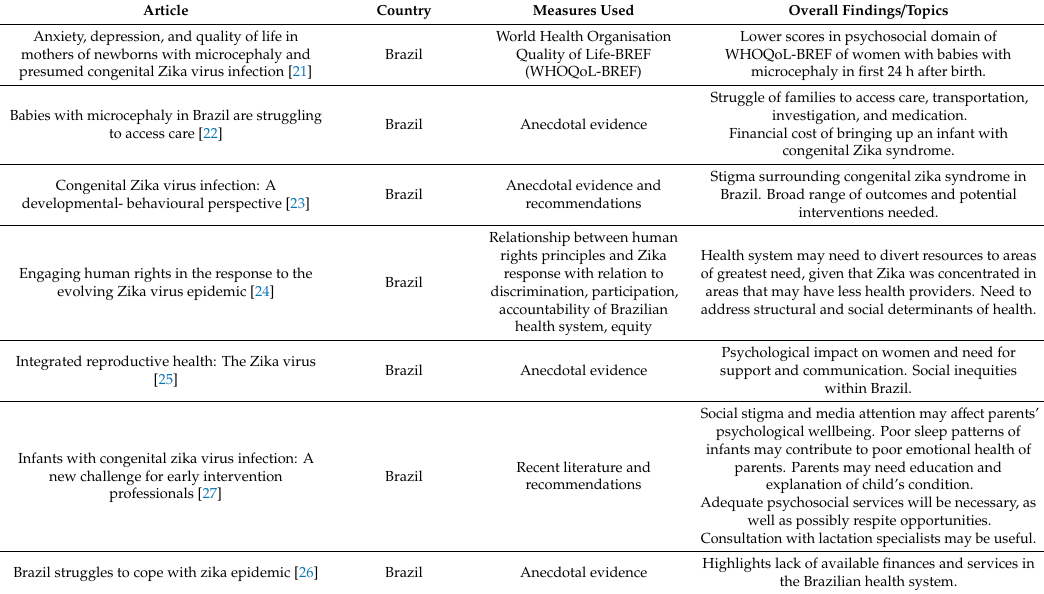
Table 1. Overview of findings from Congenital Zika Syndrome